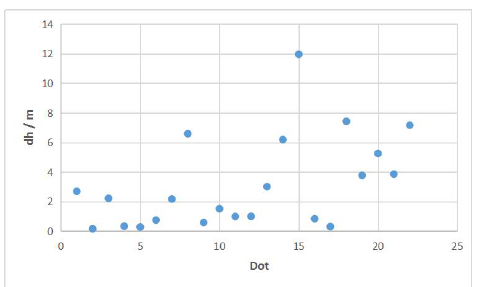
Figure 10. Errors of elevation accuracy in field 4